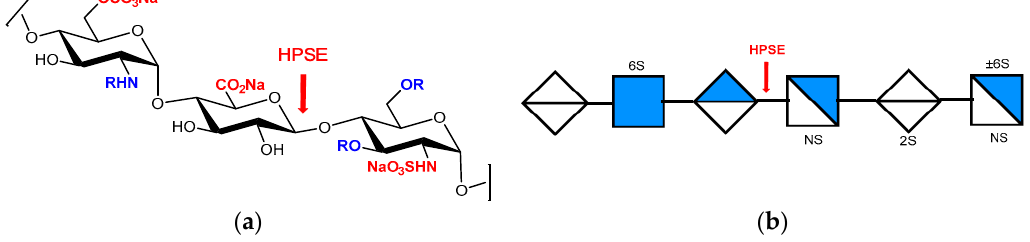
Figure 1. ( a ) Minimum HS substrate recognition sequence for heparanase. Essential charged groups in red; other charged groups which may improve affinity in blue (R = SO 3 Na); ( b ) reconstruction of the preferred HS cleavage sequences from a recent substrate specificity study [20].